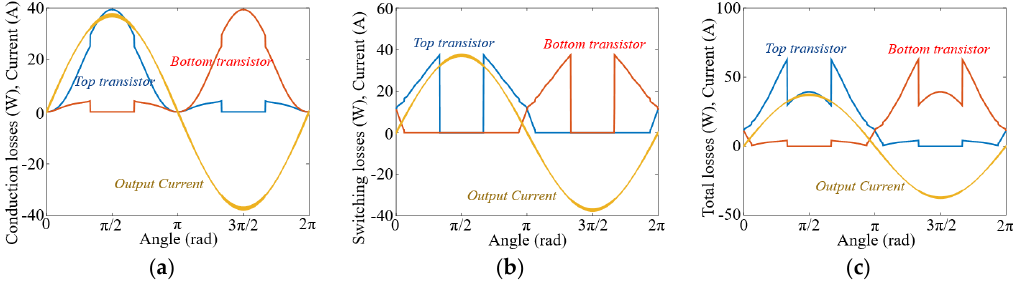
Figure 8. Instantaneous values of ( a ) conduction, ( b ) switching, and ( c ) total (conduction + switching) losses in the top and bottom switches of one bridge leg of a three-phase inverter having: V DC = 540 V, I out = 26.3A, φ = 0°, M i = 1, F sw = 50 kHz. The modulation method used was DPWM1. I out = 26.3A, ϕ = 0 ◦ , M i = 1, F sw = 50 kHz. The modulation method used was